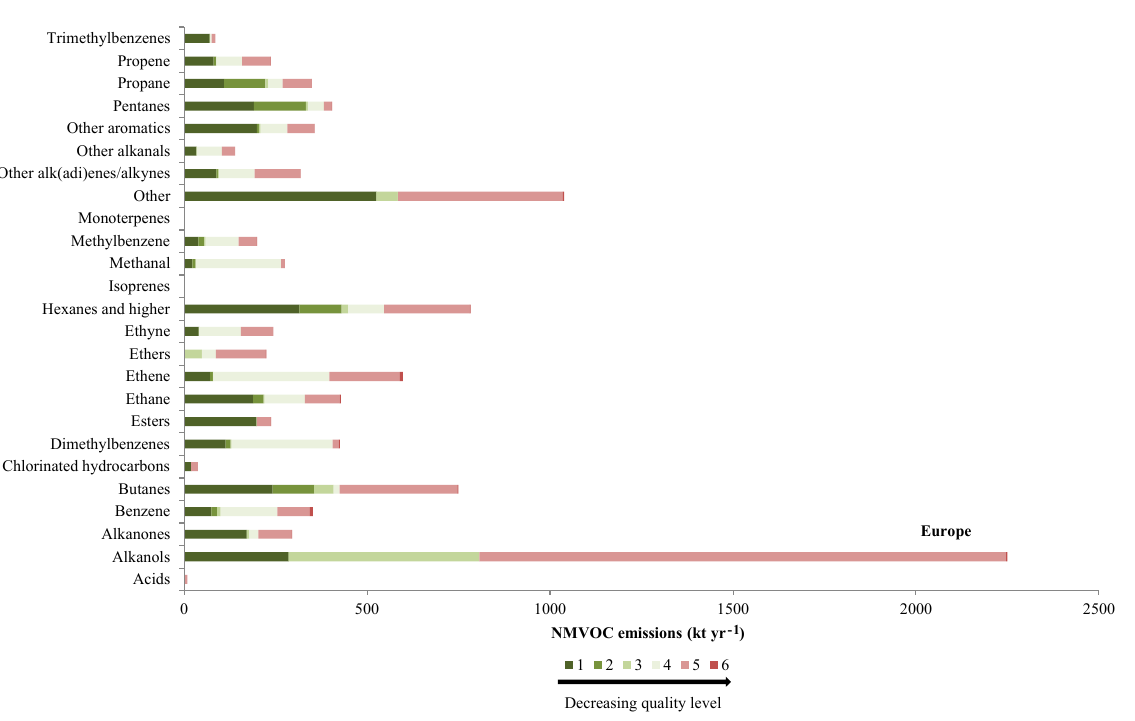
63 % of emissions of other NMVOCs are related to processes mapped with well-matched (quality code 1) speciation pro-